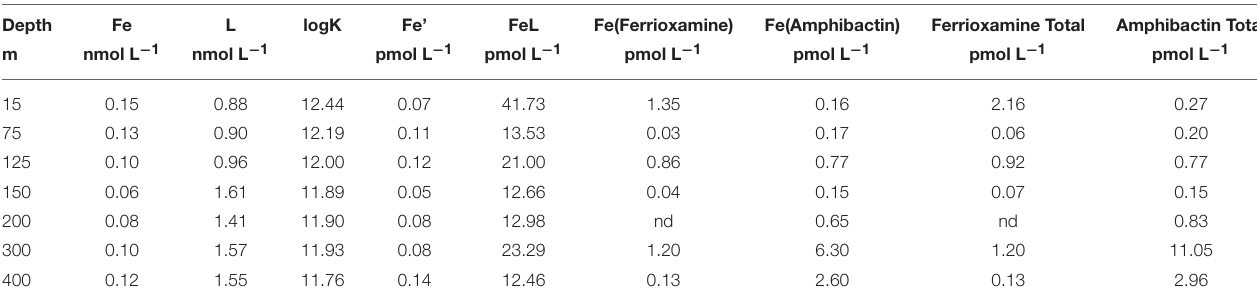
( Figure 5A ). After 3 days, concentrations of ferrioxamine E had not changed in the controls of sterilized treatments, while concentrations in the + Particles treatments remained high, within the range observed on day 1 ( Figure 5A ). The production of ferrioxamine E in + Particle treatments was also accompanied by an increase in heterotrophic bacteria compared to control treatments ( Figure 5B ). However, no amphibactins were observed in the